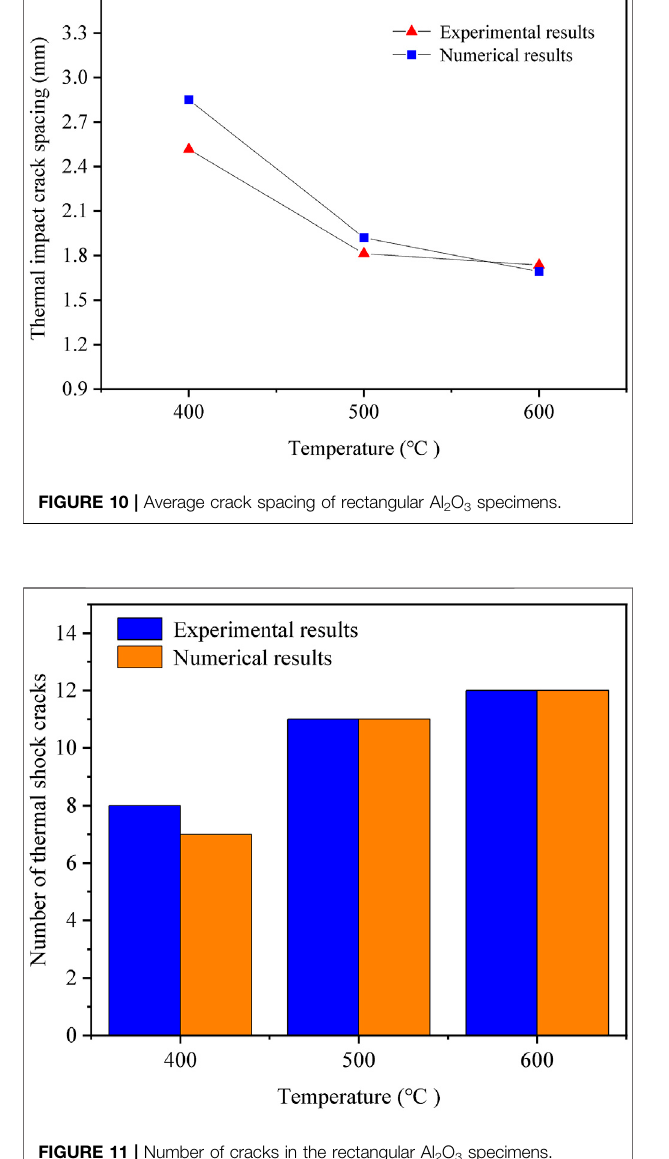
FIGURE 11 | Number of cracks in the rectangular Al 2 O 3